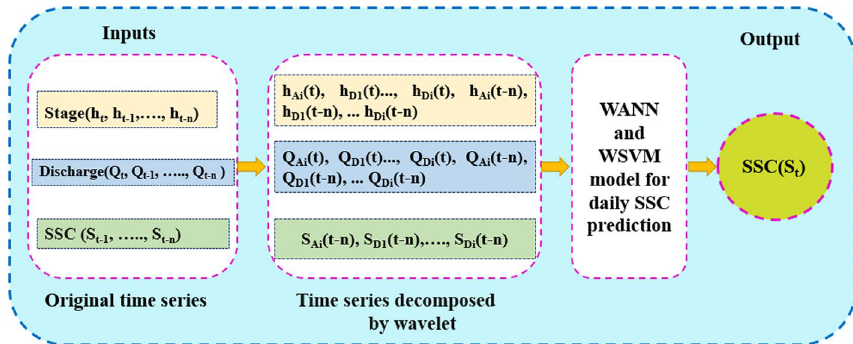
Fig. 5 Construction of proposed WANN and SVM